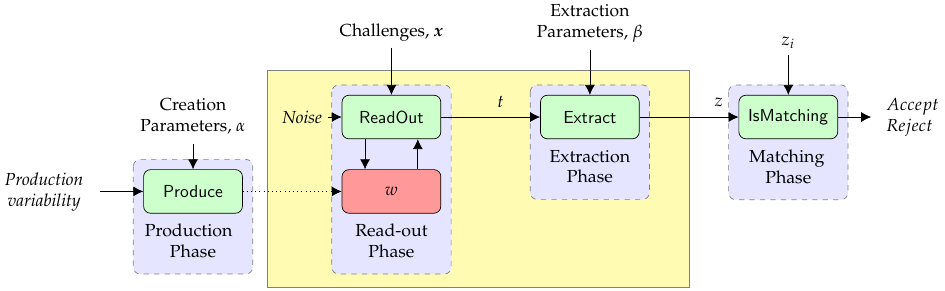
Figure 4. A generic framework for physical functions. Readout, Extraction, and Matching: three phases for object verification. Adapted from